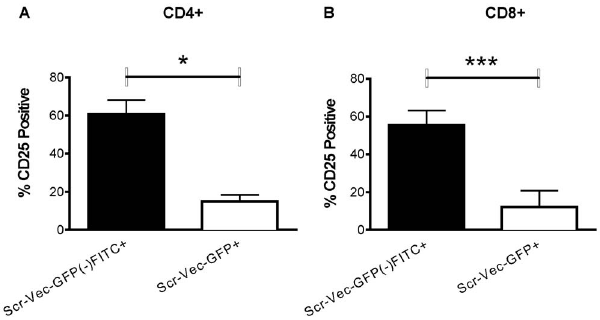
Figure 3. CD25 surface expression by flow cytometry in FITC- labeled Scr-Vec-GFP( 2 ) and Scr-Vec-GFP( + ) cells. CD25 surface expression was measured by flow cytometry. T cells from three donors were transfected with the Scr-Vec-GFP( 2 ) directly labeled with FITC (black bars) or Scr-Vec-GFP( + ) (white bars). Following 20 hours CD3/ CD28 activation cells were stained for flow cytometry analysis. Cells were gated on the total live T cell population by forward and side- scatter analysis, followed by gating on either FITC + or GFP + cells, then CD4 + (A) or CD8 + (B) populations were analyzed for CD25 expression and compared by Student’s paired t-test. Mean and SEM are shown and P # 0.05 was considered to be significant.